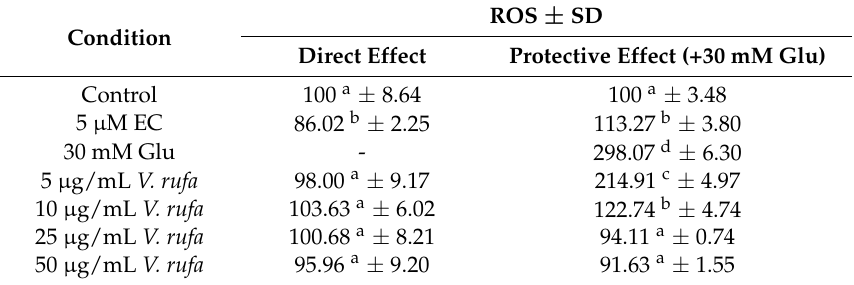
Table 2. Direct and protective effect of Vochysia rufa treatment on ROS generation in EA.hy926. ROS generation was evaluated in EA.hy926 cells treated for 2 h with noted concentrations of EC or the Vochysia rufa (Vr) extract (direct effect). To test the protective effect cells were treated for 24 h with noted concentrations of EC or Vochysia rufa (Vr) extract and then submitted to 30 mM glucose (30 mM Glu) for 2 h. Values are means ± SD. n = 4 (ROS). Values are expressed as a percent relative to control condition. Different letters in each column indicate statistically significant differences ( p < 0.05) among